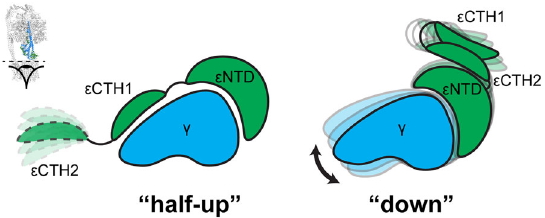
Fig. 9 Schematic of clamping by ε CTH1. When the ε CTH1 is in the half-up state and bound to subunit γ , the central stalk is clamped and increases the stiffness of the rotor. When ε CTH1 is in the down state, the central stalk is no longer clamped and has increased